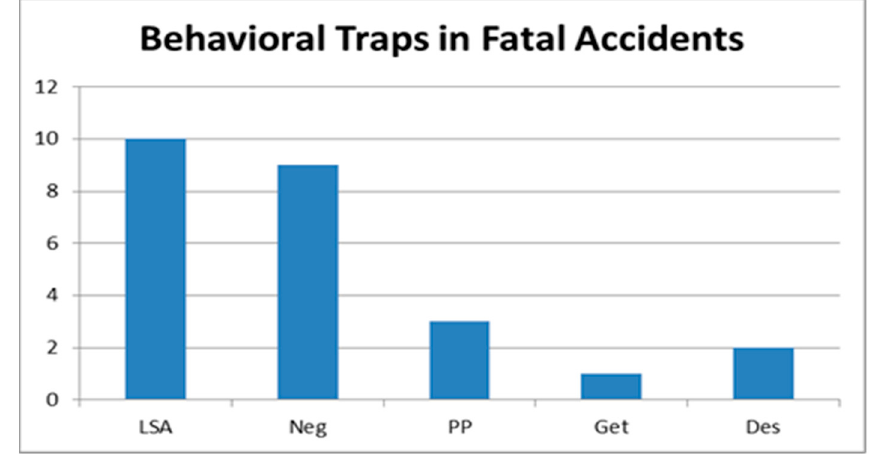
Figure 2. Behavioral traps in fatal accidents only.